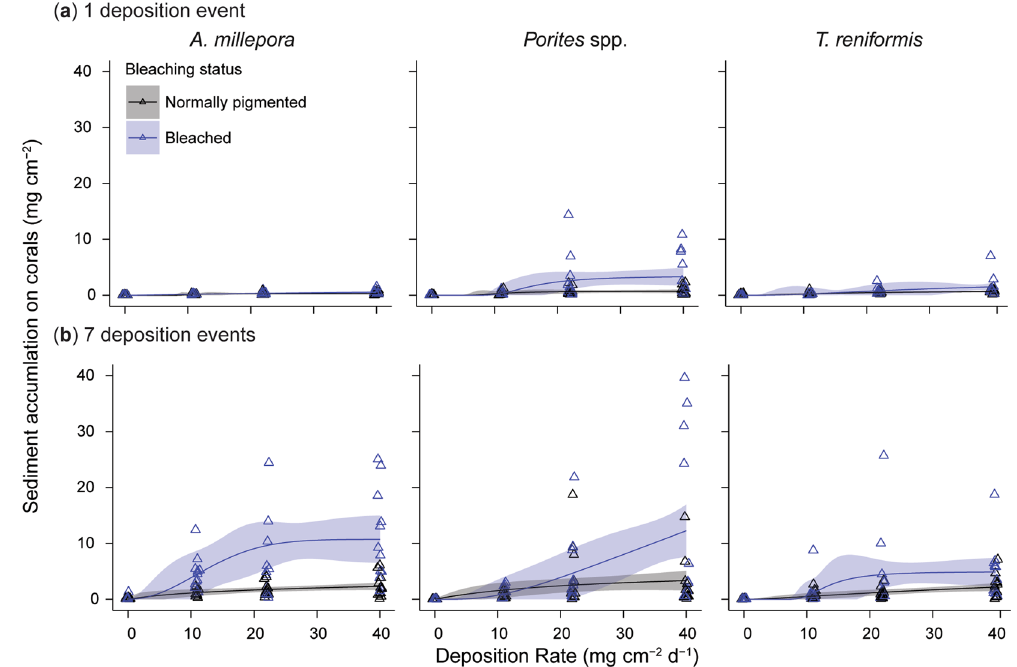
Figure 4. Sediment accumulation on bleached and normally-pigmented corals. The amount of sediment (mg cm − 2 ) accumulated on each fragment of A . millepora , Porites spp. and T . reniformis across 4 deposition rate treatments for both normally-pigmented (black) corals and bleached (blue) fragments after: ( a ) 1 deposition event, and ( b ) a further 6 deposition events. Raw data is presented (triangles) with modelled values (lines) and 95% credible intervals